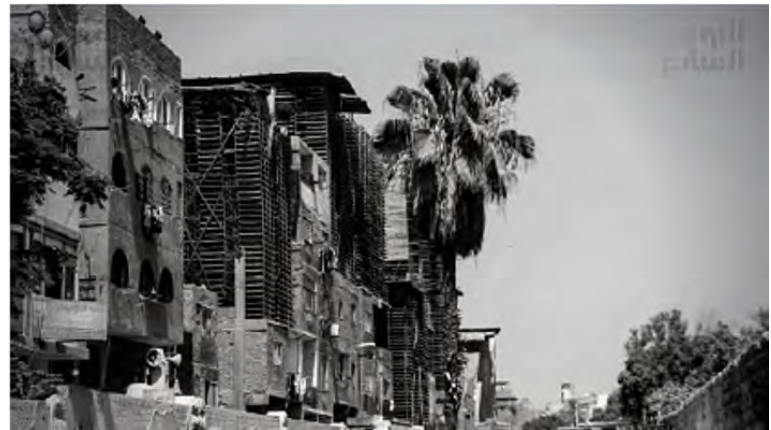
Figure 4. Tanneries wooden towers (Students research)